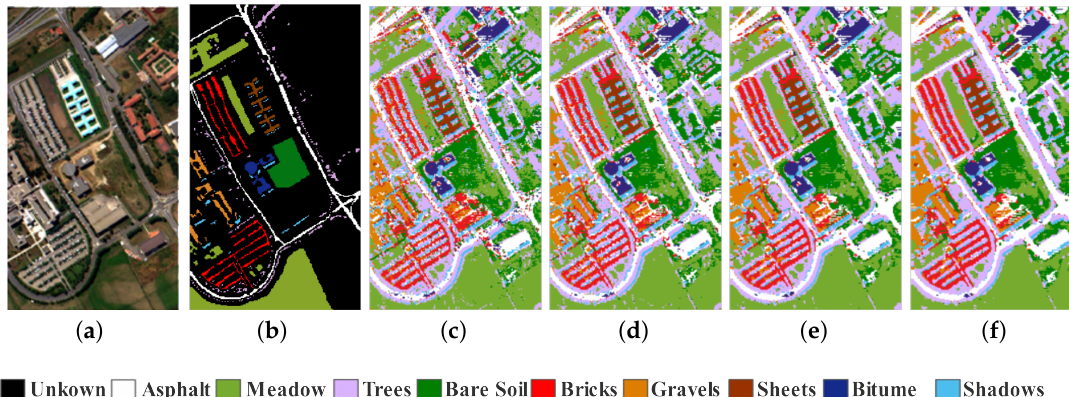
Figure 11. Thematic maps and OA (%) resulting from the ASSP-SCNN with different spatial window size on PaviaU dataset with nine classes. ( a ) Pseudocolor image. ( b ) Ground-truth map.